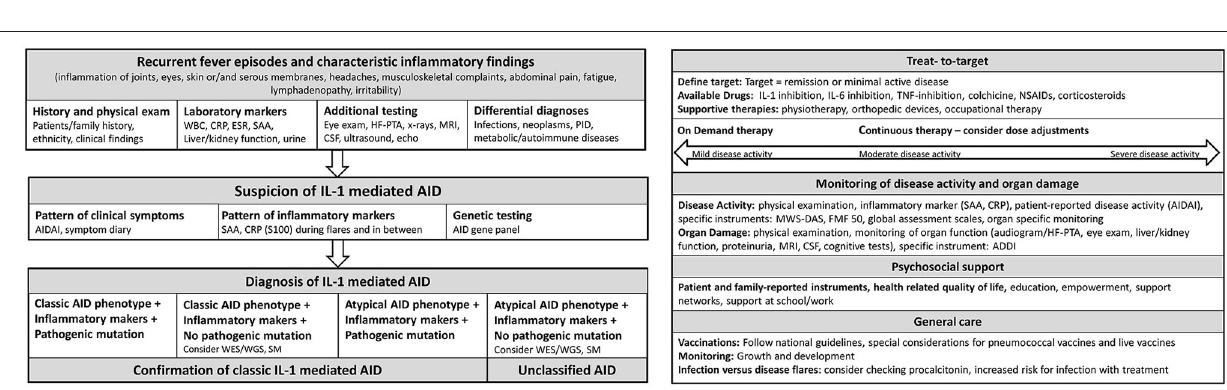
FIGURE 1 | IL-1 inflammasome structure, cytokine release, and treatment target. Inflammasome formation is induced by a variety of triggers. Activated NLRP3 subsequently nucleates ASC forming filaments via PYD-PYD interactions and drives procaspase-1 filament formation through CARD-CARD interactions. Caspase-1 mediates cleavage of pro-IL-1 β and pro-IL-18 to IL-1 β and IL-18. [Modified from McCoy et al. ( 19), Lachmann et al. (20), Broderick (21)]. CARD, caspase activation and recruitment domain; LRR, leucine-rich-repeats; PYD, Pyrin domain; ASC, Apoptosis related speck-like protein containing CARD.